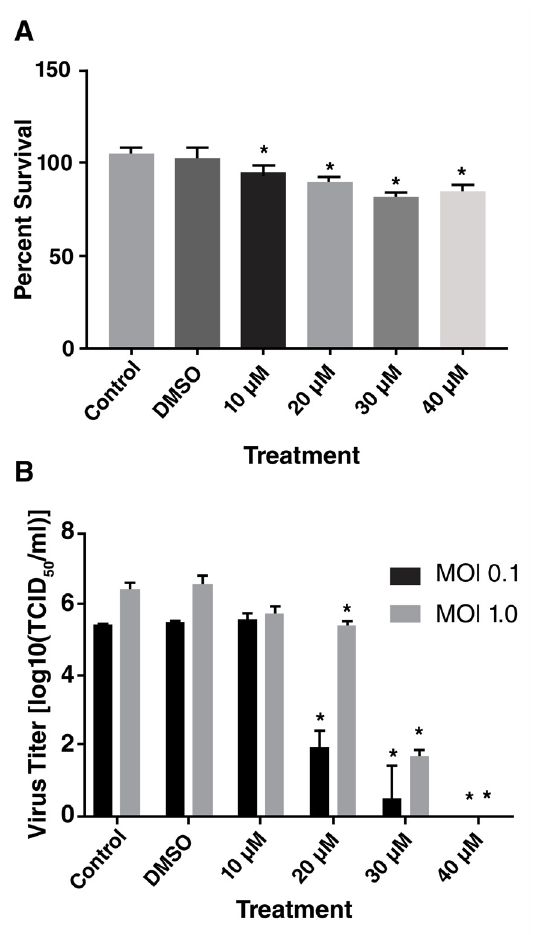
Figure 3. Effect of MF on hPDF cell proliferation and CHIKV181/25 replication. ( A ) hPDF cells were treated with increasing doses of MF and MTT assay was done to determine the proliferation of cells. Since, MF was dissolved in dimethyl sulfoxide (DMSO), a DMSO concentration equivalent to concentration in 40µM dose was used in the assay. The control was saline treated cells. Significant effects on cell proliferation was observed in MF treated group compared to saline treated control groups. ( B ) hPDF Cells were treated 4–6 h with MF and infected with CHIKV181/25 with either MOI 0.1 or 1. Virus titer in the cell supernatants was measured at 24 h post